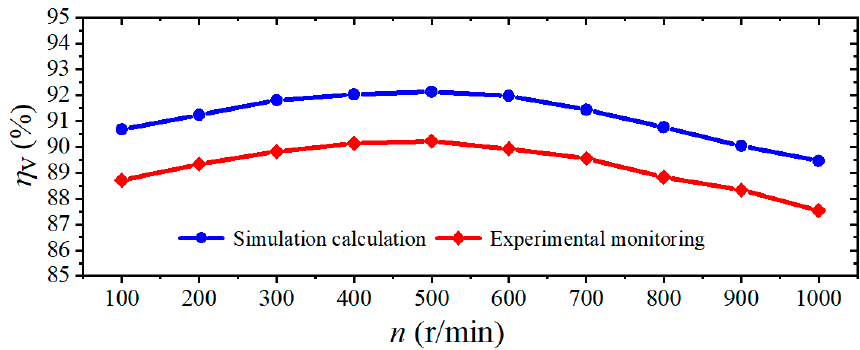
Figure 16. VE at different rotating speeds.